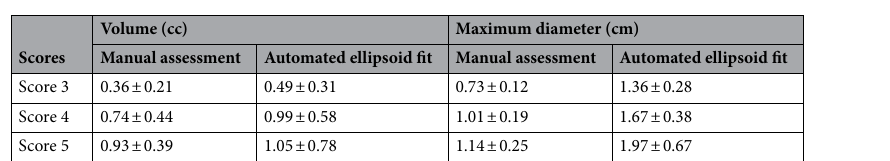
Table 1. Tumour volume and maximum-diameter for different PI-RADS v2.1 scores, in terms of mean ± standard deviation (SD); SD was calculated across all subjects within each